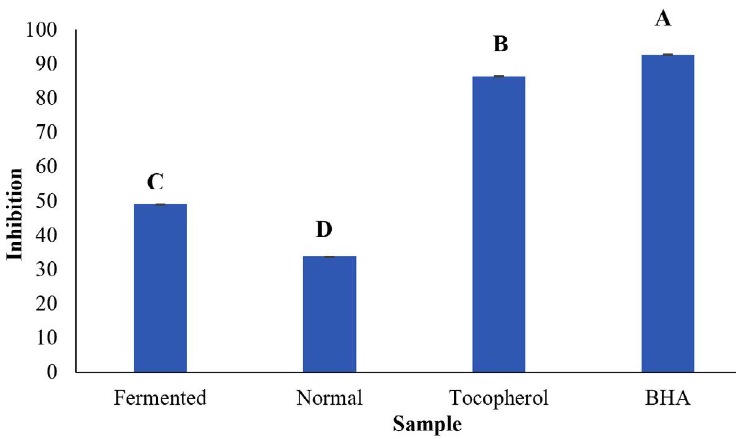
Fig. 1. DPPH radical scavenging activity of the fermented and normal Cyperus rotundus extract Mean of different letters are significantly different at p < 0.05